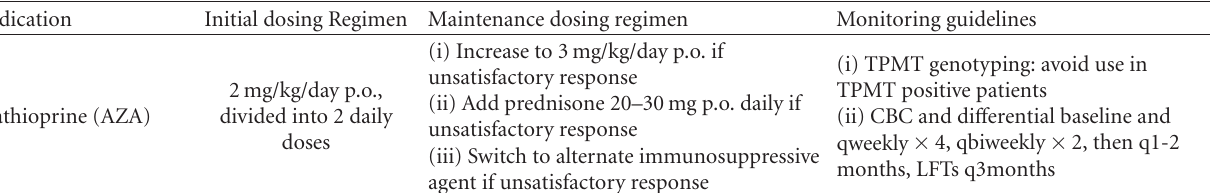
Table 1: Recommended first-line agents in the preventive treatment of